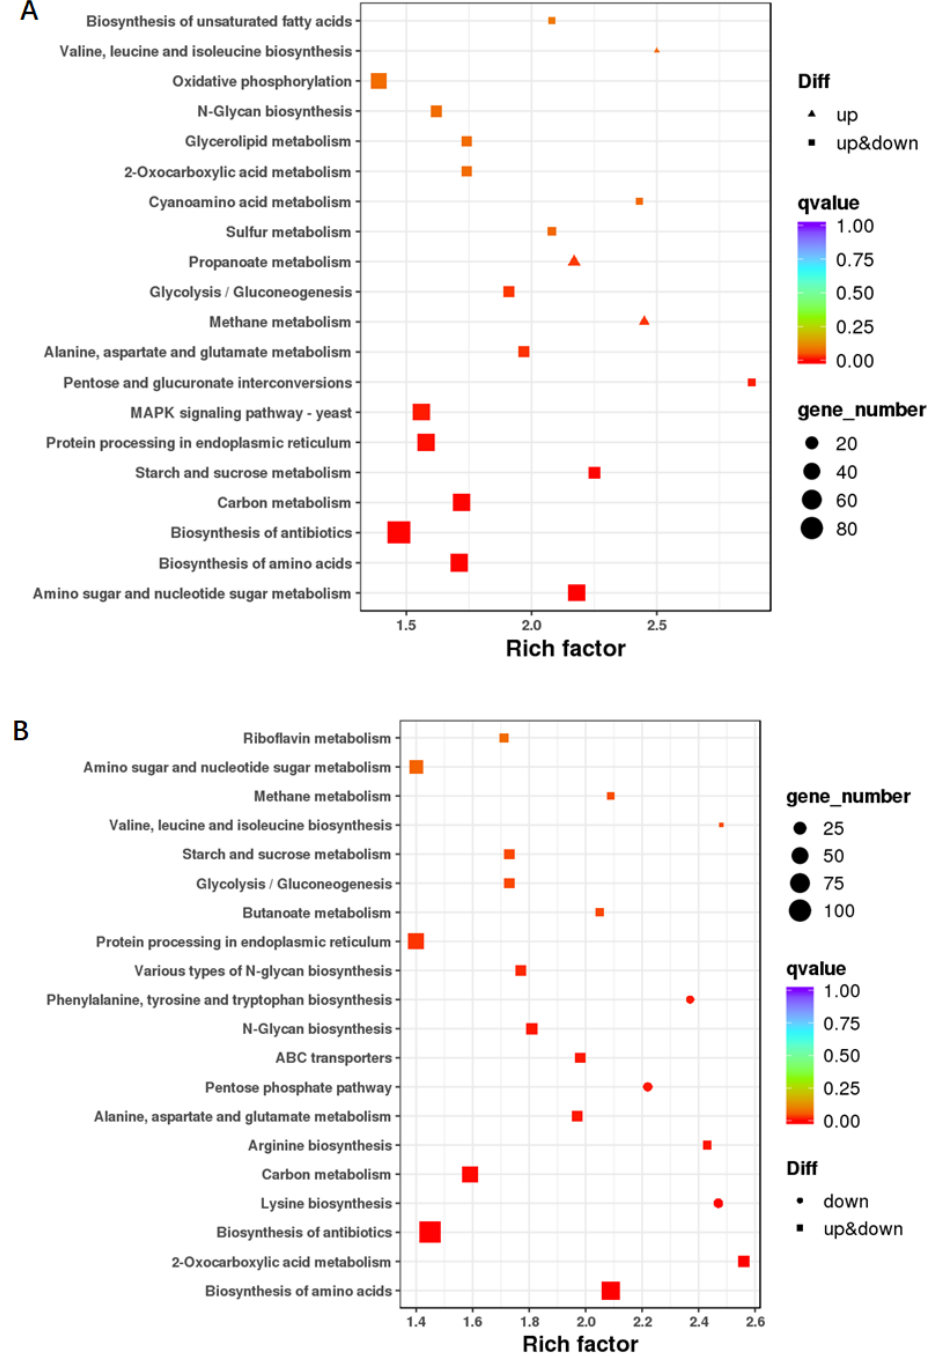
Figure 8. Kyoto Encyclopedia of Genes and Genomes (KEGG) enrichment analyses of differentially expressed genes (DEGs) in C stage vs. pre-C stage ( A ) and C stage vs. post-C stage ( B ). “Rich factor” refers to the ratio of the number of differentially expressed transcripts to the total number of transcripts for each pathway; the larger the rich factor, the higher the degree of enrichment. The q value indicated the P-value after the multiple hypothesis test corrections ranging from 0 to 1; the closer it is to 0, the more significant the enrichment considering a false discovery rate (FDR) ≤ 0.01 as the threshold.